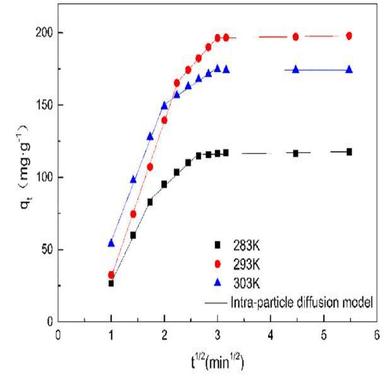
Intra-particle diffusion model.